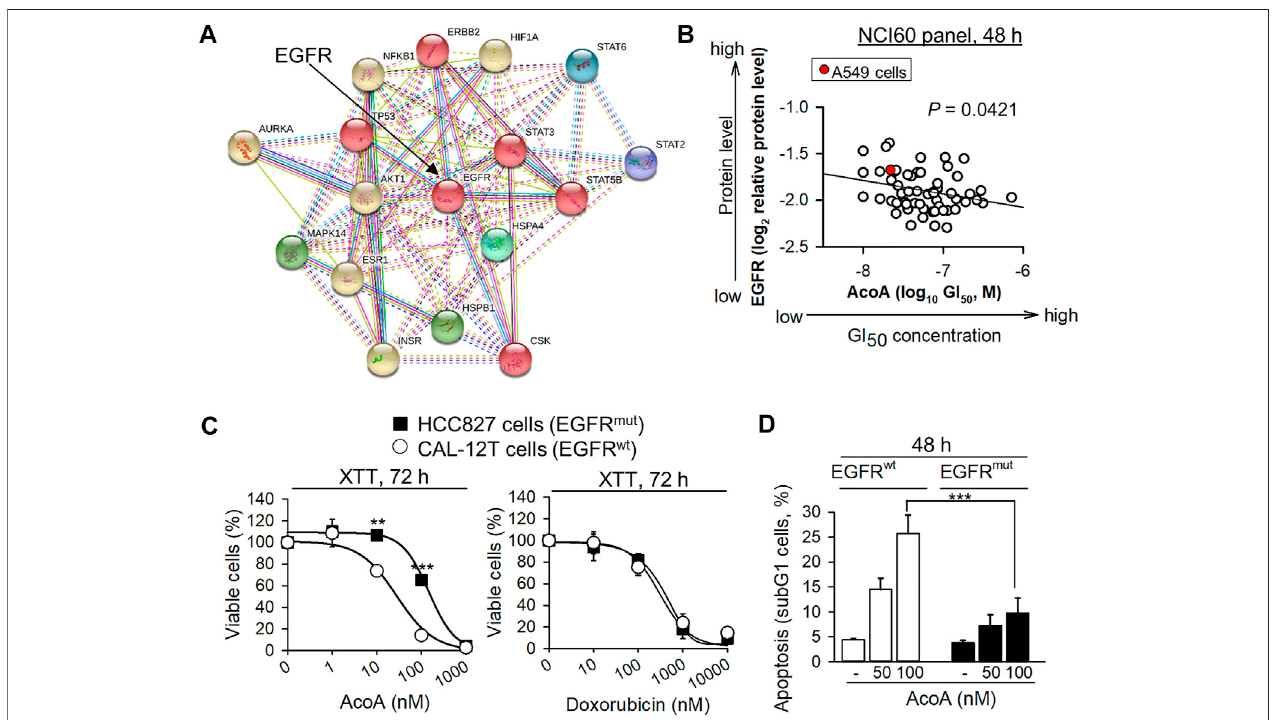
FIGURE5| AcoA-mediatedcytotoxicityincancercellsdependsonEGFR. (A) FunctionalinteractionsofproteinsaffectedbyAcoAaccordingtoproteomepro fi ling arrays were analyzed by the STRING database. 6 clusters were selected. Inter-cluster edges are represented by dashed lines. (B) AcoA-induced GI 50 (concentration of 50% growth inhibition) values of the NCI60 cancer cell panel positively correlate to EGFR expression levels of the respective cell lines (original data were obtained from NCIdatabase).ReddotindicatesA549cellline.Pearsoncorrelationtest. (C) NSCLCcellsexpressingconstitutivelyactiveEGFR(EGFR mut ,HCC-827)arerelatively resistant to AcoA. HCC-827 or EGFR wt NSCLC cells (CAL-12T) were analyzed by XTT ( N (cid:1) 3). For comparison, the response to the conventional chemotherapeutic doxorubicin was measured in parallel (XTT, N (cid:1) 6). (D) AcoA induces an apoptotic subG1 cell population in EGFR wt , but not in EGFR mut cells as analyzed by fl ow cytometry of propidium iodide stained cells ( N (cid:1) 4). Data are mean ± SEM of at least N (cid:1) 3, ** p < 0.01, *** p < 0.001.